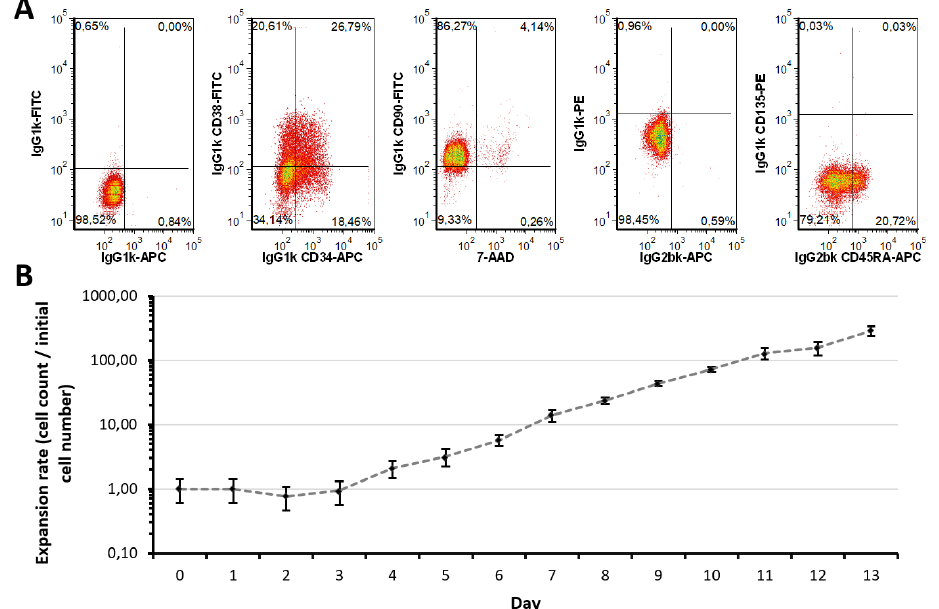
Figure 1. Characteristics of expanded CD34 + HSPC population. ( A ) Expression of HSPC surface markers in the progenitor population in comparison to corresponding isotype controls. Representative dot plots from three independent experiments ( n = 3) are shown. ( B ) Growth characteristics of CD34 + HSPC during the expansion phase. Data are represented as mean ± SD ( n = 3). Alive cell numbers were determined by trypan blue exclusion method, using a hemacytometer.